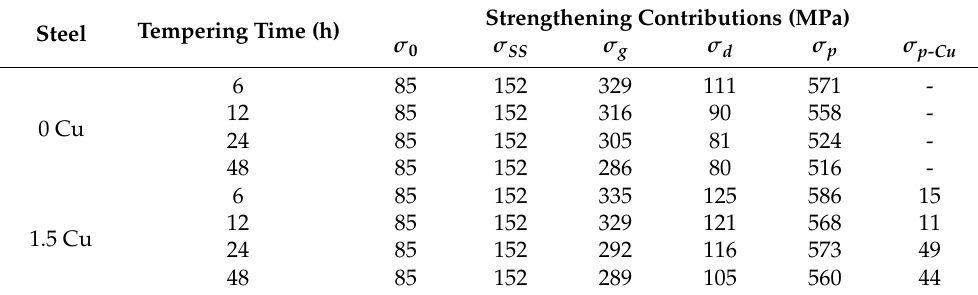
Table 5. Strengthening contributions—lattice friction stress ( σ 0 ), solid solution strengthening ( σ SS ), grain boundary strengthening ( σ g ), dislocation strengthening ( σ d ), strengthening from precipitates ( σ p ), and strengthening only from Cu-precipitates ( σ p-Cu ). Strengthening Contributions (MPa) Steel Tempering Time (h) σ 0